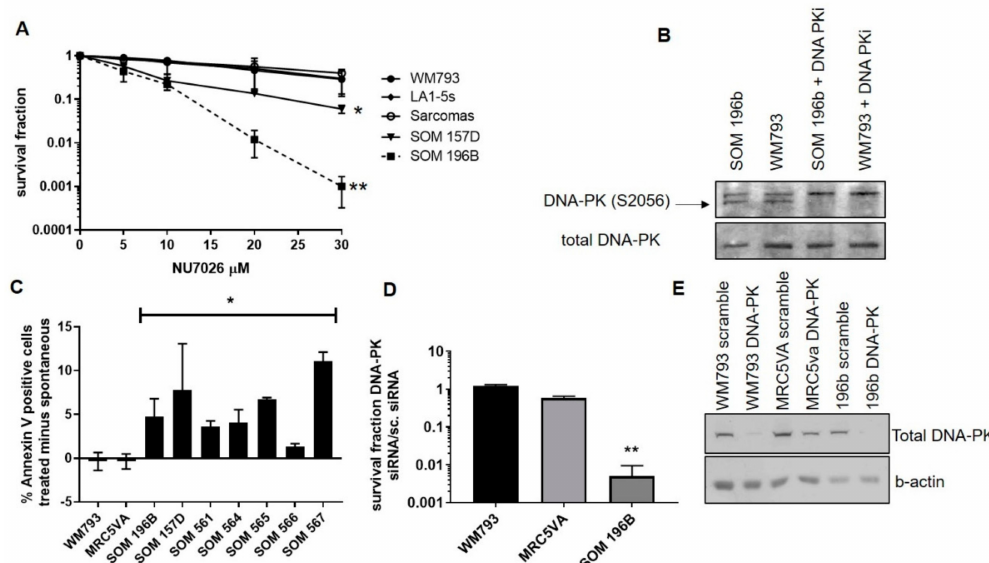
Figure 3. The sensitivity of UM cells to inhibition of DNA-PK. ( A ) UM cell lines SOM 157D and 196B were sensitive to DNA-PK inhibitor NU7026 when compared to the cutaneous melanoma (CM) cell line WM793, LA1-5s and an array of sarcoma cell lines (** P = < 0.001 and * P =< 0.05 respectively). ( B ) Inhibition of DNA-PK following treatment with NU7026 was confirmed by western blot in SOM 196B. ( C ) UM cell lines SOM 196B and SOM 157D and five available UM STCs show elevated